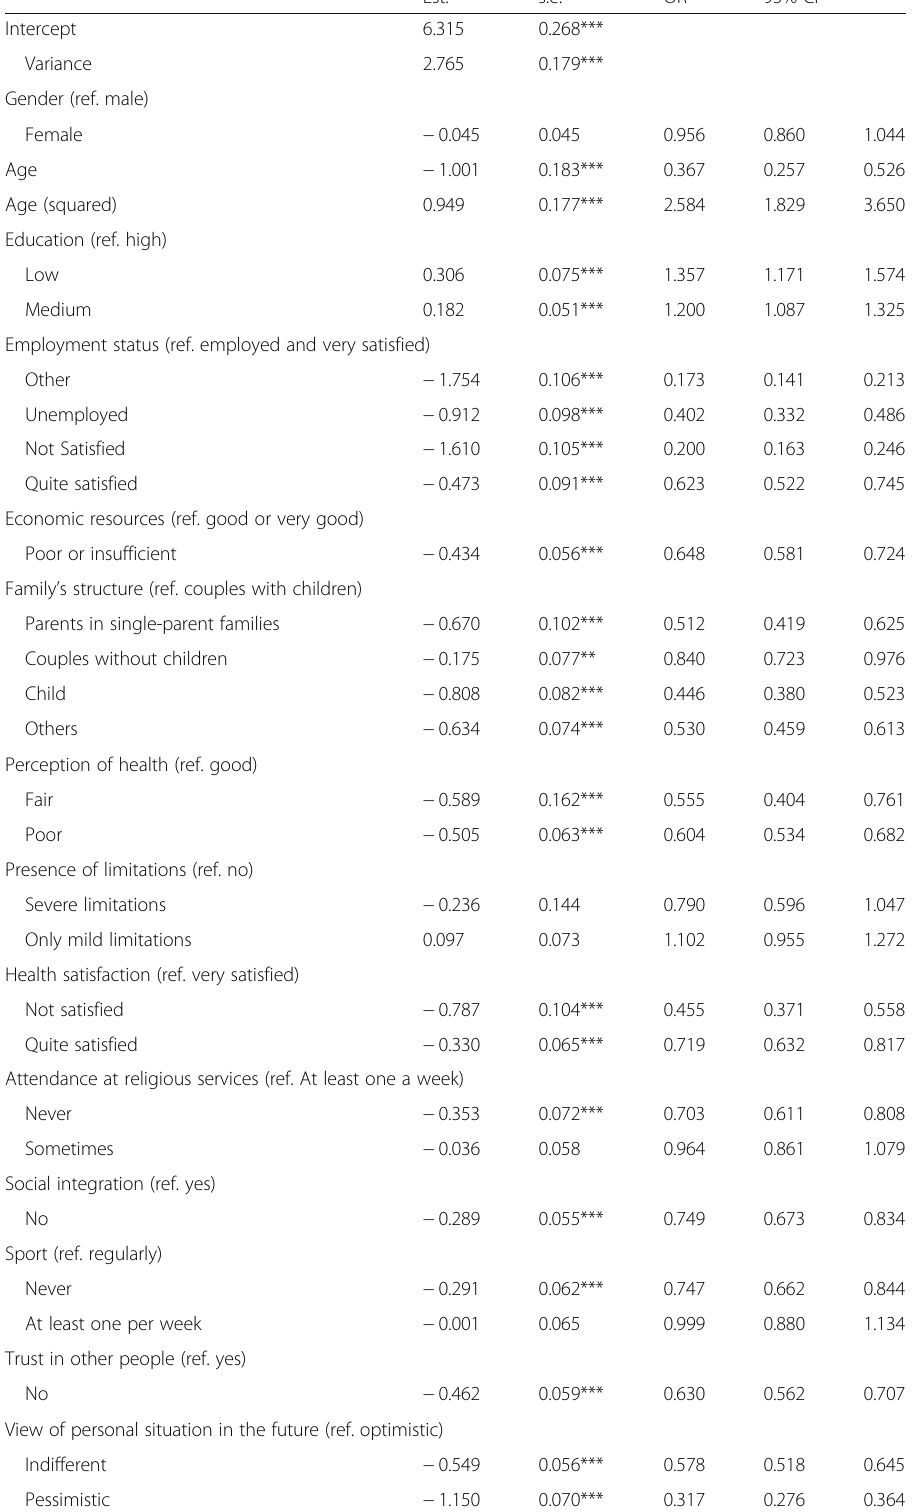
Table 3 Coefficient estimates ( β ) and their standard errors (s.e.), odds ratios (OR), and their 95% confidence interval of the binary logistic multilevel model for the life satisfaction (probability of being satisfied)